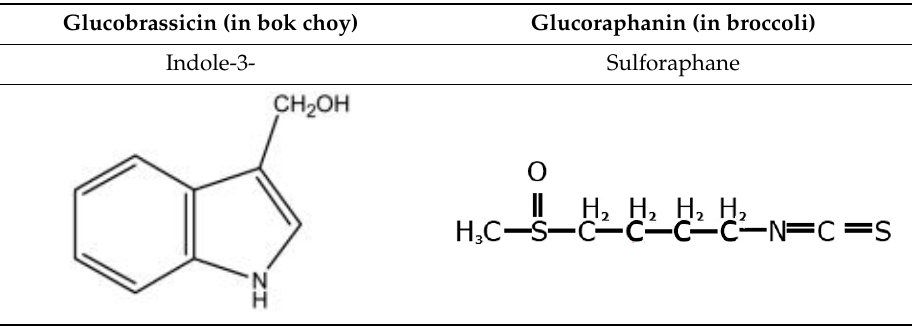
Table 5. Di ff erences in glucosinolate structures. Table 5. Differences in glucosinolate structures. Table 5. Differences in glucosinolate